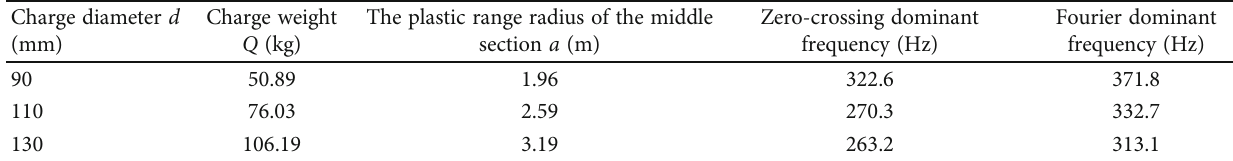
Figure 7: Waveforms and spectra of the elastic-plastic boundary under di ff erent charge diameters. Table 5: Radius of plastic zone under di ff erent charge